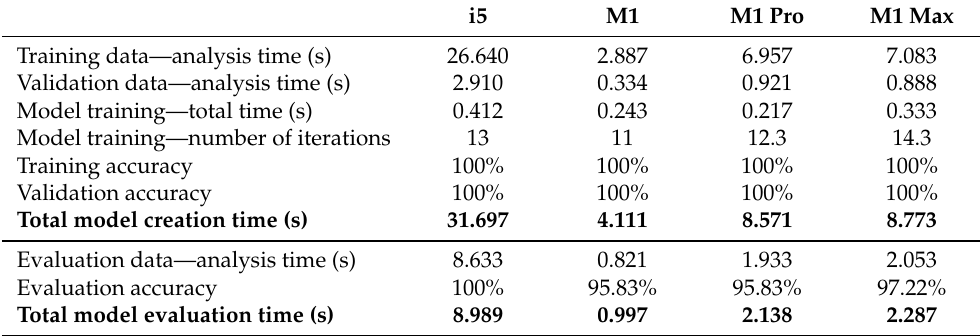
Table 6. Average results for the test performed using the ‘ClassifierData’ dataset.